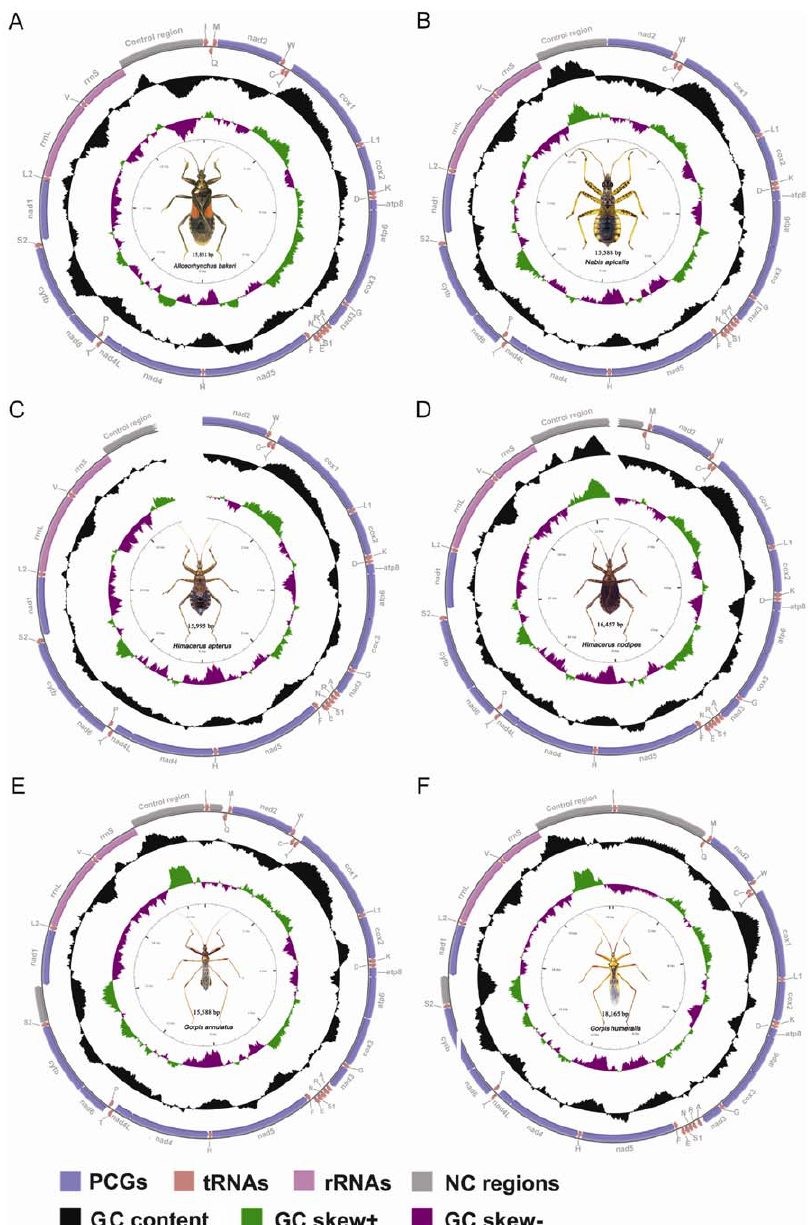
Figure 1. Mitochondrial maps of six damsel bugs. Direction of gene transcription is indicated by arrows. PCGs are shown as blue arrows, rRNAs as purple arrows, tRNAs as red arrows and large NC regions ( . 100 bp) as cyan rectangles. tRNAs are labeled according to single-letter IUPAC-IUB abbreviations (L1: UUR; L2:CUN; S1:AGN; S2:UCN). The GC content is plotted using a black sliding window, as the deviation from the average GC content of the entire sequence. GC-skew is plotted as the deviation from the average GC-skew of the entire sequence. Ticks in the inner cycle indicate the sequence length.